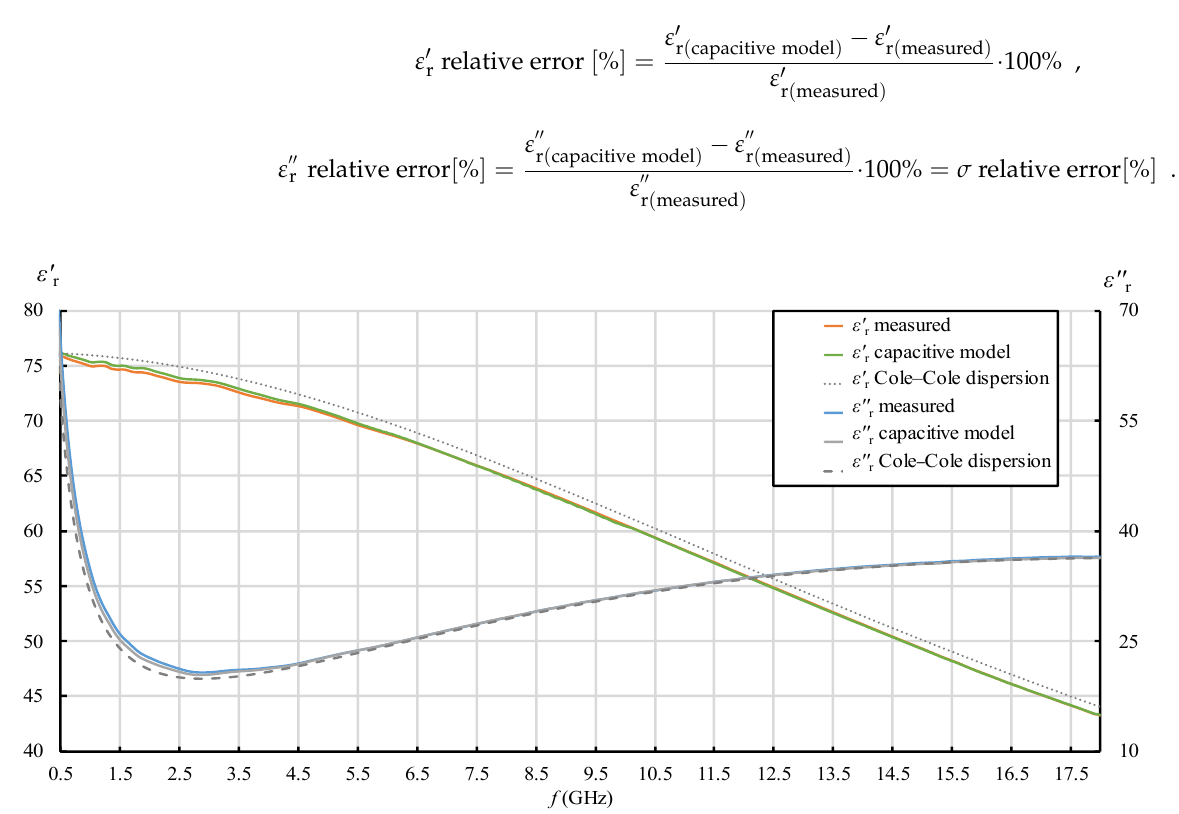
Figure 7. 𝜀 r′ and 𝜀 r″ for 0.154M (physiological) saline: measurement result as a final value obtained from the measurement software (“measured”); measurement result obtained by postprocessing the reflection coefficient using the simple capacitive-load model (“capacitive model”) and dispersion model (“Cole – Cole dispersion”).